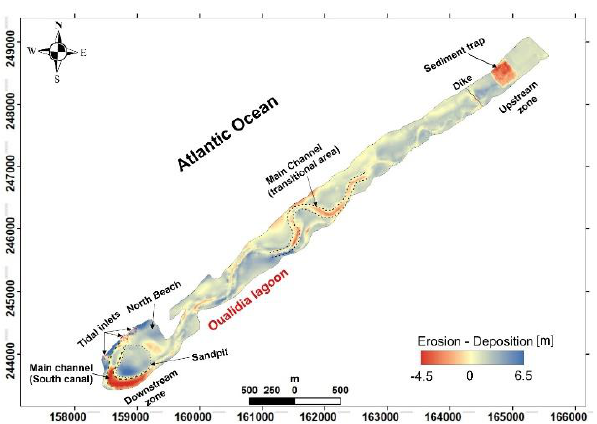
Figure 9. The erosion-accumulation zones in the Oualidia Lagoon after 6 years (2006-2012).